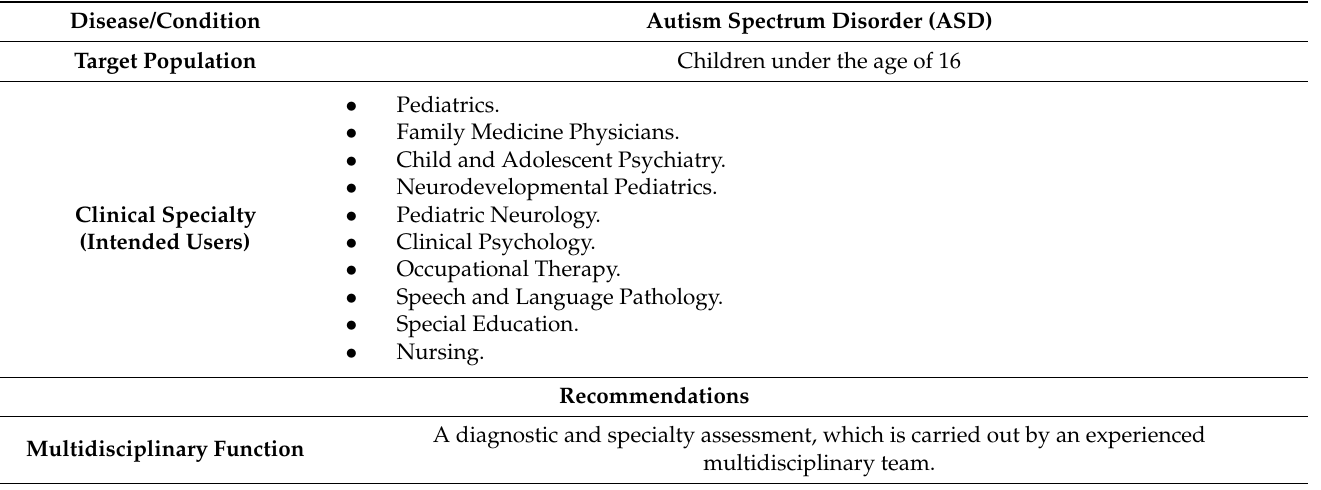
Table 1. Description of the CPG-targeted population and its intended